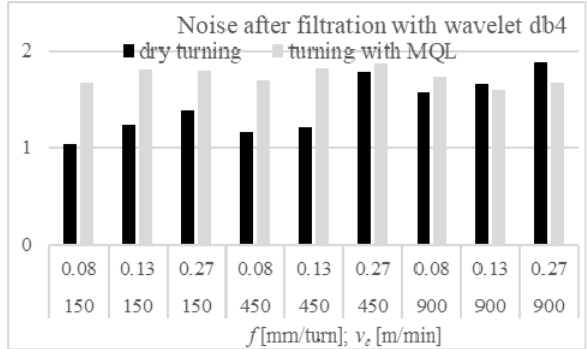
Figure 14. Cutting force Fc in aluminium composite turning with diamond coated carbide tool